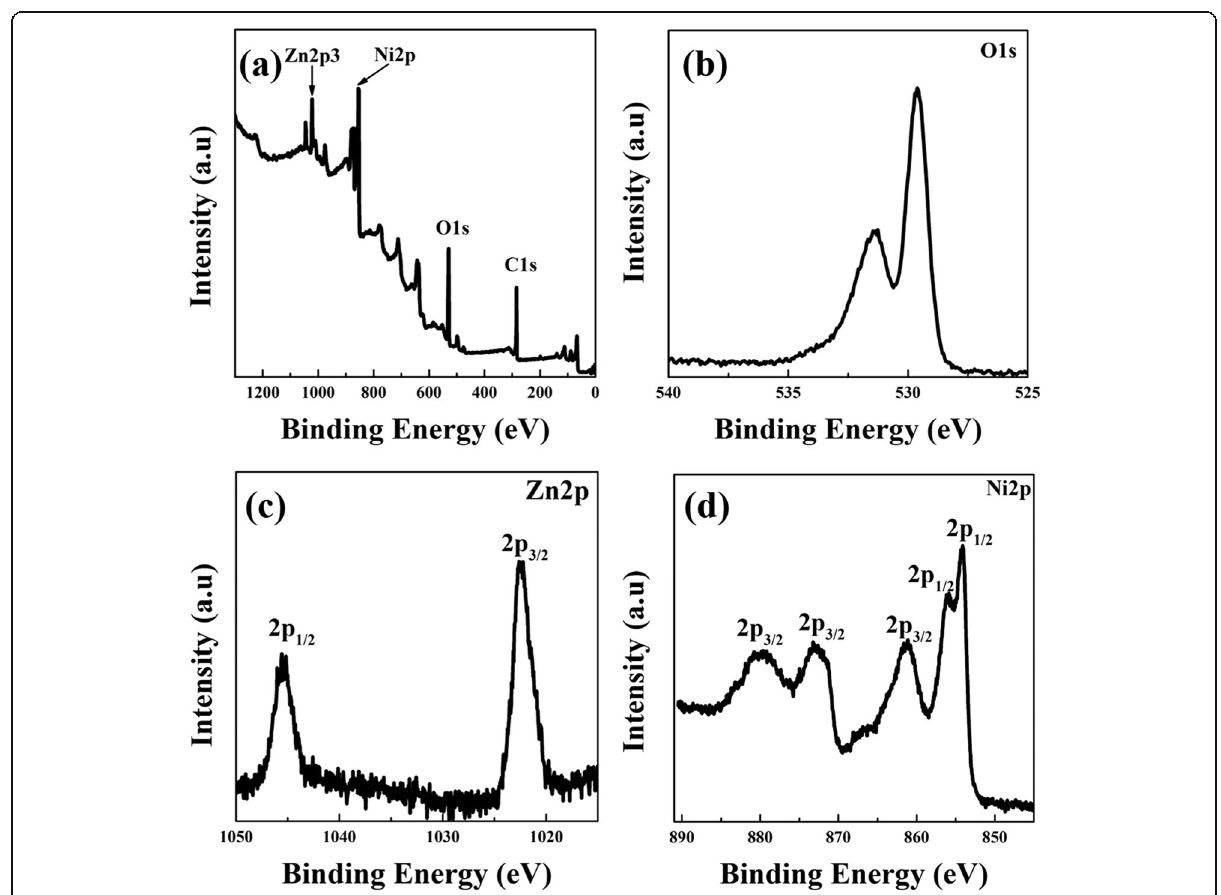
Fig. 6 XPS spectra of ZN2. a Survey spectra. b O 1s. c Zn 2p. d Ni 2p